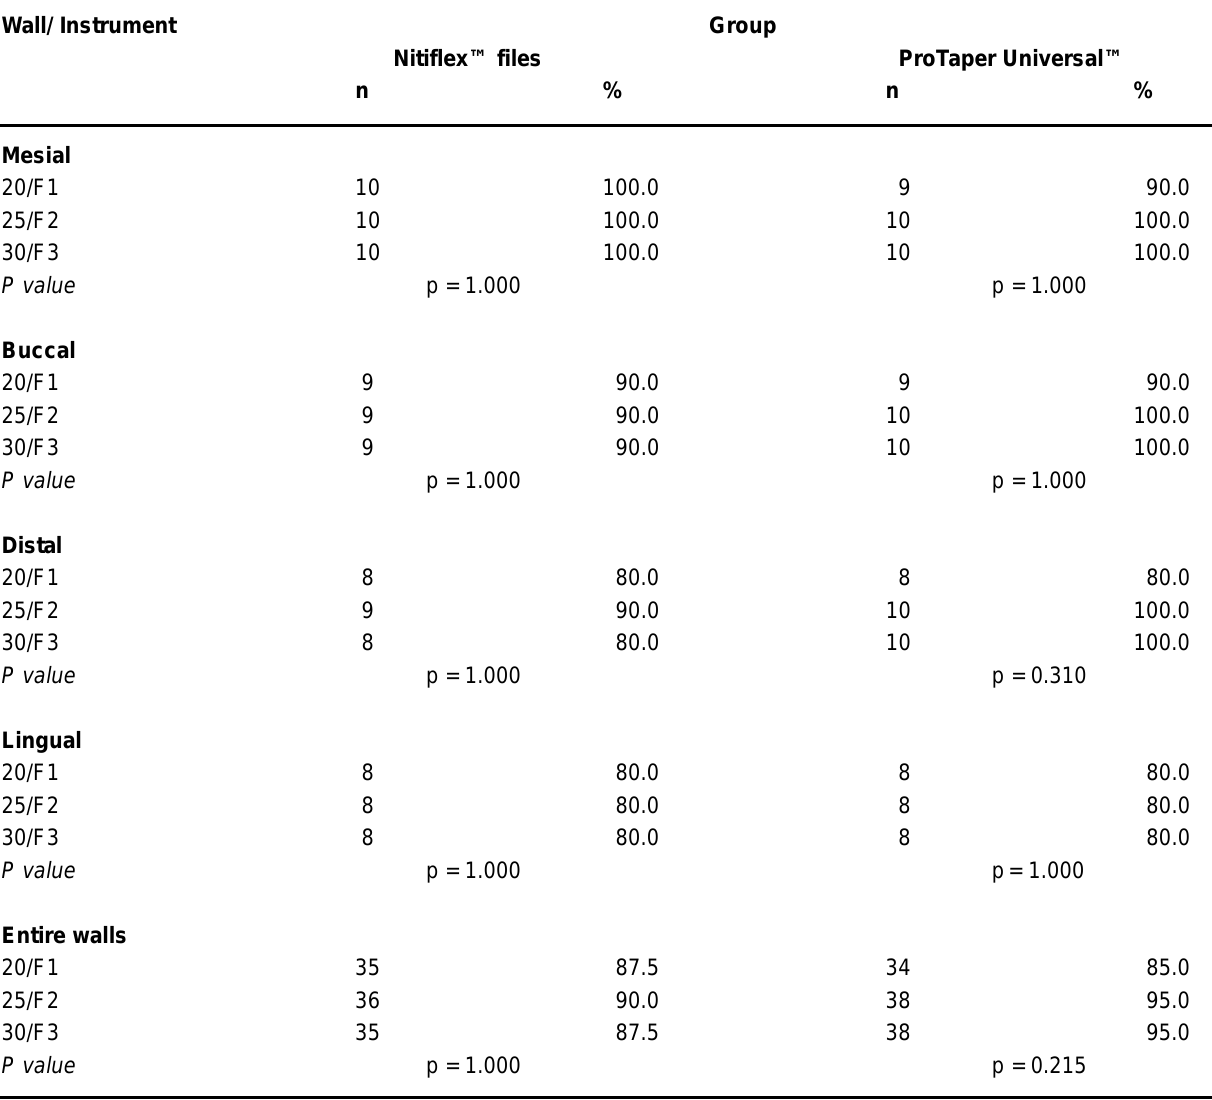
N= number of walls